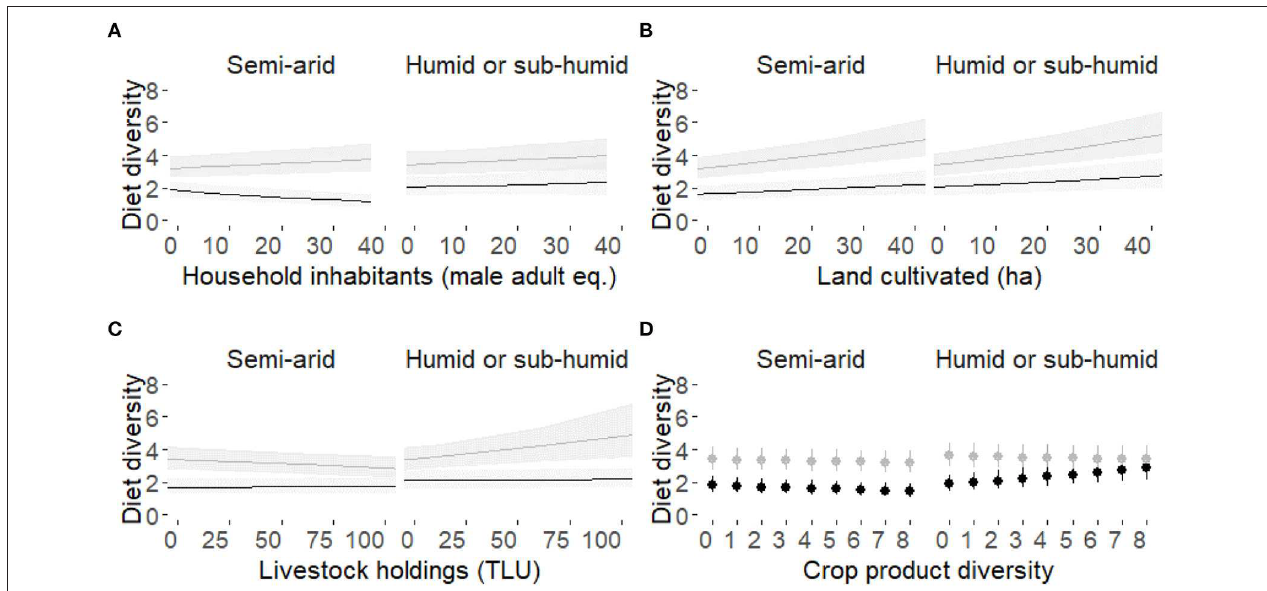
FIGURE 2 | Predicted associations between MHDD (count of food categories) and (A) household inhabitants (adult eq), (B) land cultivated, (C) livestock holdings (Tropical Livestock Units), (D) crop product diversity in the flush (gray line/point) and lean (black line/point) periods by agro-ecological zone.